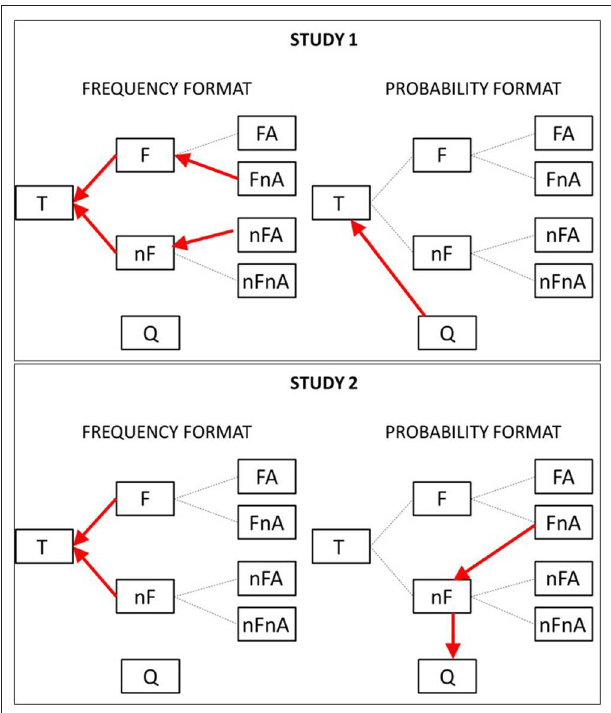
FIGURE 5 | Discriminative transitions shown using arrows on the original tree diagram, for the frequency (Left) and probability (Right) conditions, and for study 1 (Top) and study 2 (Bottom)